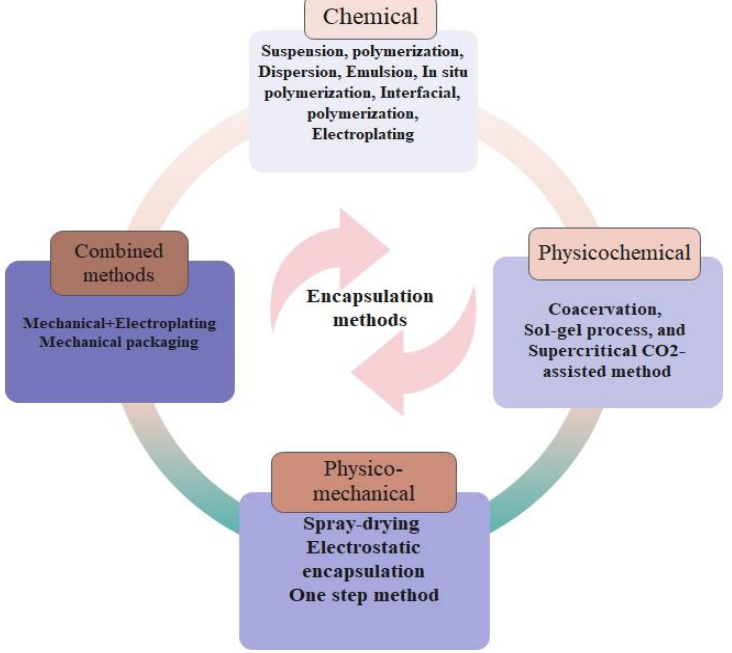
Figure 4. Representation of different techniques of PCC fabrication methods.